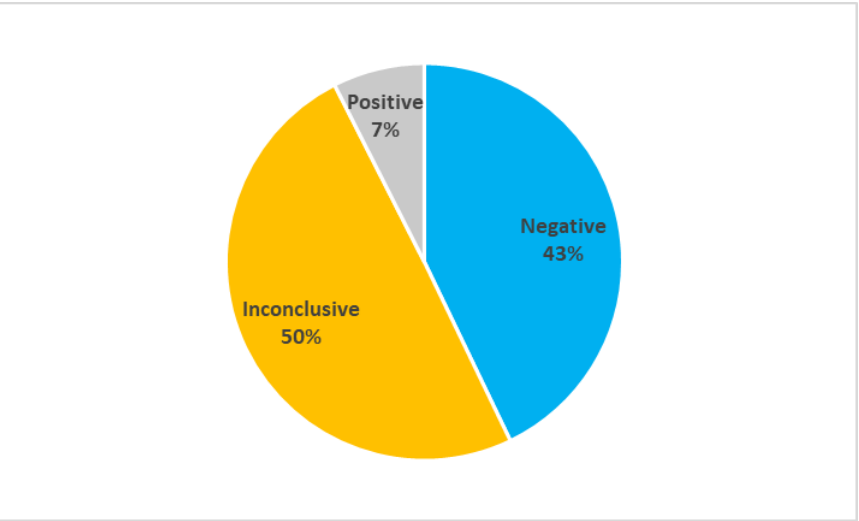
Figure 1. Results of genetic tests (n = 147). The pie reports the percentage of negative, inconclusive, and positive test on the whole population considered.